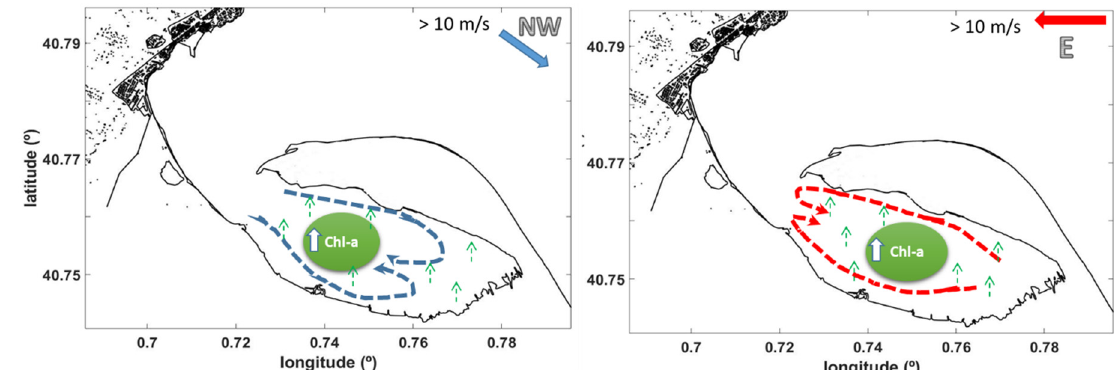
Figure 7. Water circulation and Chl a concentration patterns in Fangar Bay. The dashed lines show the water circulation within the bay, and the blue and red arrow shows the wind direction, including the wind intensity minimum value (approx.) for stratification breakage and consequently an increase in the Chl a concentration. The small green arrows show the resuspension of matter (nutrients or Chl a -containing biomass) from the bottom caused by winds.